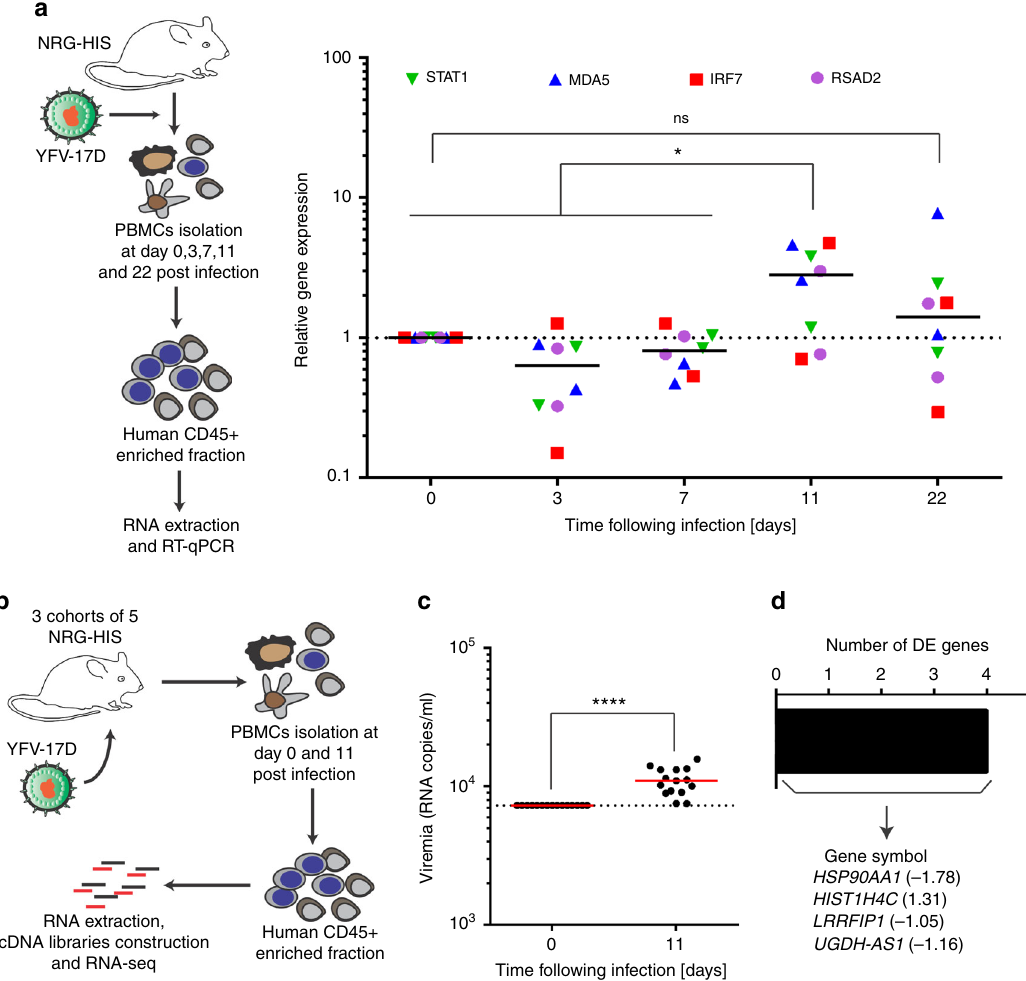
Fig. 2 Limited transcriptomic response to YFV-17D infection in NRG-HIS mice. a Relative expression of a set of four anti-viral genes (green, STAT1 ; blue, MDA5 ; red, IRF7 ; and purple, RSAD2 ) in the PBMCs of NRG-HIS mice following infection with YFV-17D. Expression of each gene was assessed by RT-qPCR in human peripheral CD45 + cells at different time points post infection (day 0, 3, 7, 11, and 22 post infection). Each dot represents the average expression of a given gene within a cohort of 4 NRG-HIS mice. For each time point, the grand median is shown and represent the median of the cumulated expression of the four genes. Dotted line represents the gene expression level at baseline ( n = 2 cohorts of four NRG-HIS mice each). * p ≤ 0.05, ns non-signi fi cant (two-way ANOVA). b Schematic representation of the procedure to characterize the PBMC transcriptomic signature of NRG-HIS mice following YFV-17D infection. c YFV-17D serum viremia at days 0 and 11 post infection in the NRG-HIS mice used for transcriptomic pro fi ling. ( + ) RNA copies per ml were quanti fi ed by RT-qPCR. Red horizontal lines represent median viremia at each time point. Limit of detection (dotted line) is shown ( n = 15). **** p ≤ 0.001 (Wilcoxon – Mann – Whitney test). d Number of signi fi cantly differentially expressed (DE) genes ( p adj ≤ 0.05) in the PBMCs of NRG-HIS mice following YFV-17D infection. The names of the only four DE genes is depicted, followed with their respective log 2 fold